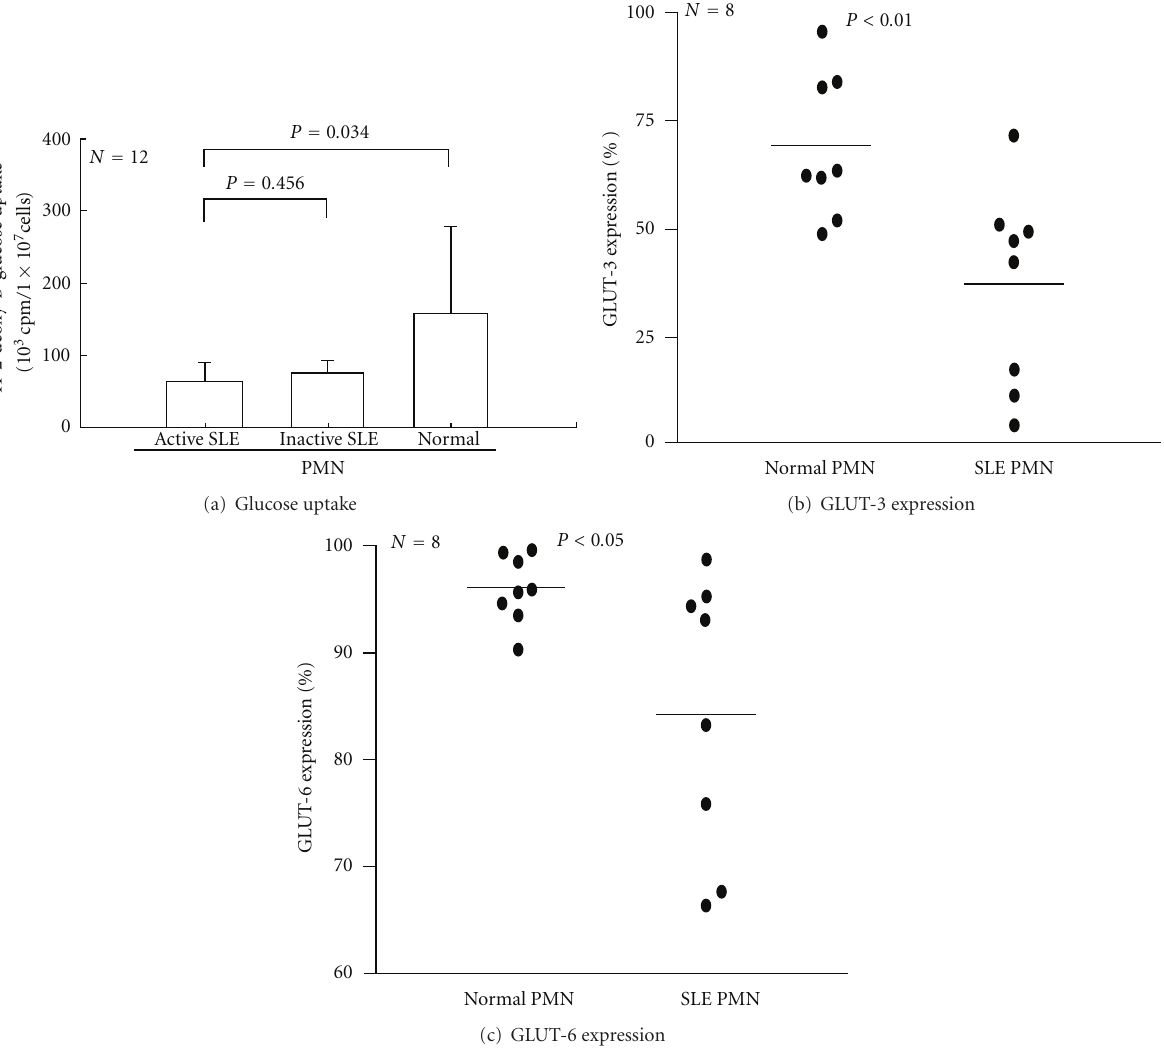
Figure 3: Comparison between normal and SLE-PMN glucose uptake and expression of glucose transporter type 3 (GLUT-3) and type 6 (GLUT-6). (a) Glucose uptake of the cells was detected by 3 H-2-deoxy- d -glucose incorporation after 24-hour incubation. (b) Expression of GLUT-3 on normal and active SLE-PMN. (c) Expression of GLUT-6 on normal and active